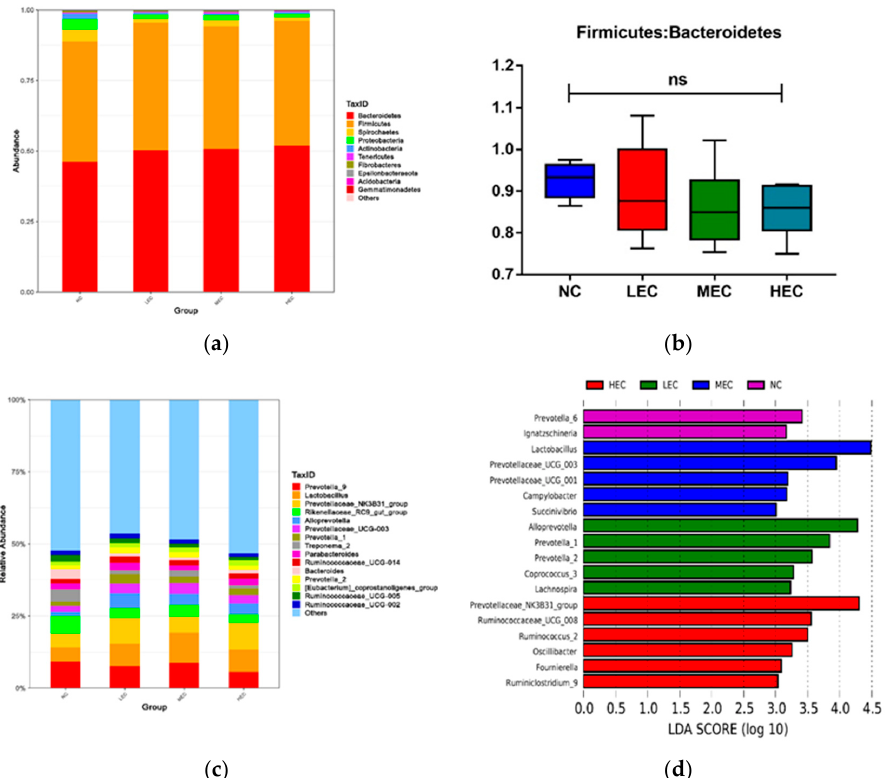
Figure 2. Microbial community structure from the fecal samples of piglets in experiment 2 ( n = 6). ( A ) represents the relative abundances of the top 15 bacterial strains at the genus level ( B ) is the ratio of Firmicutes/Bacteroidetes. ( C ) is the top 10 relative abundances of bacterial strains at the phylum level. ( D ) represents the LEfSe analysis showing the LDA scores (>3.0). Different superscripts indicate significant differences ( p < 0.05).